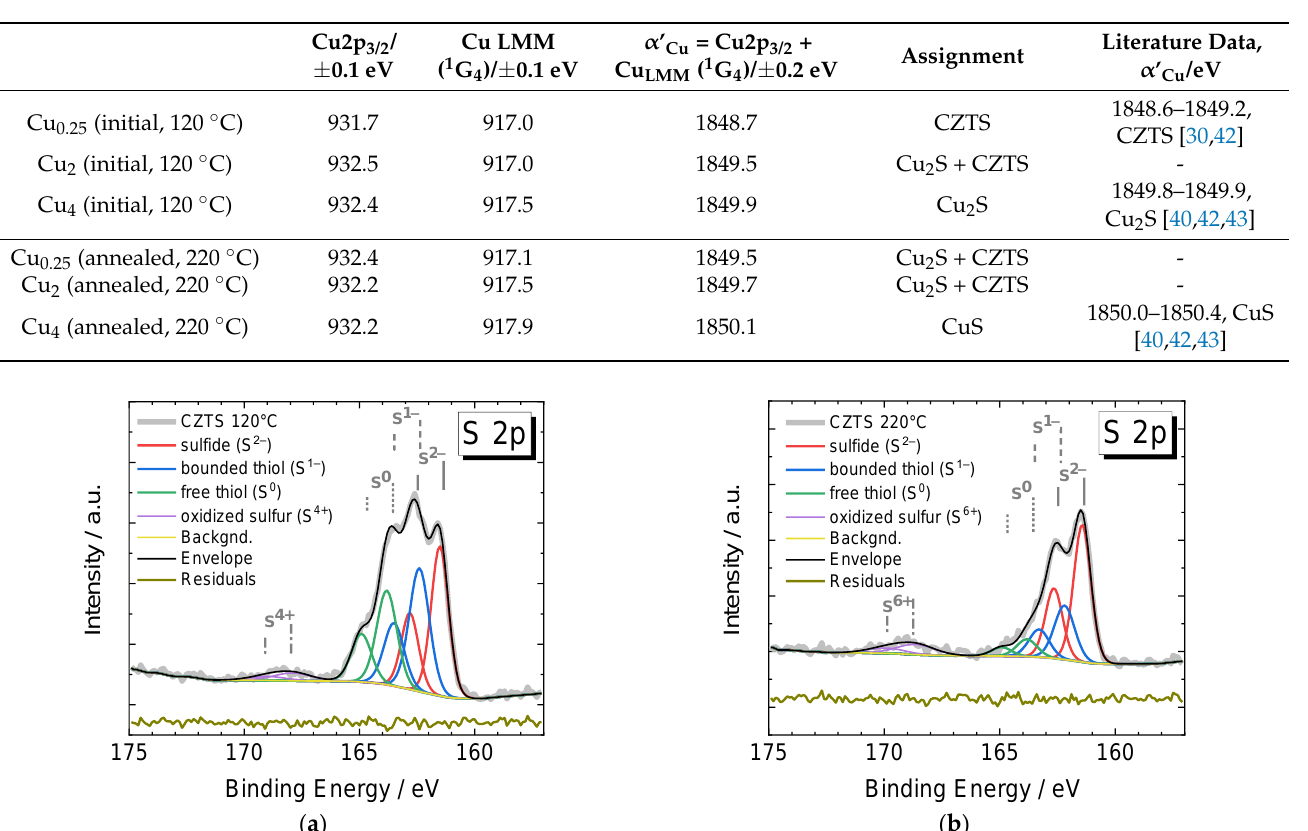
Auger spectra can be found in the Supplementary Materials (Figure S3).